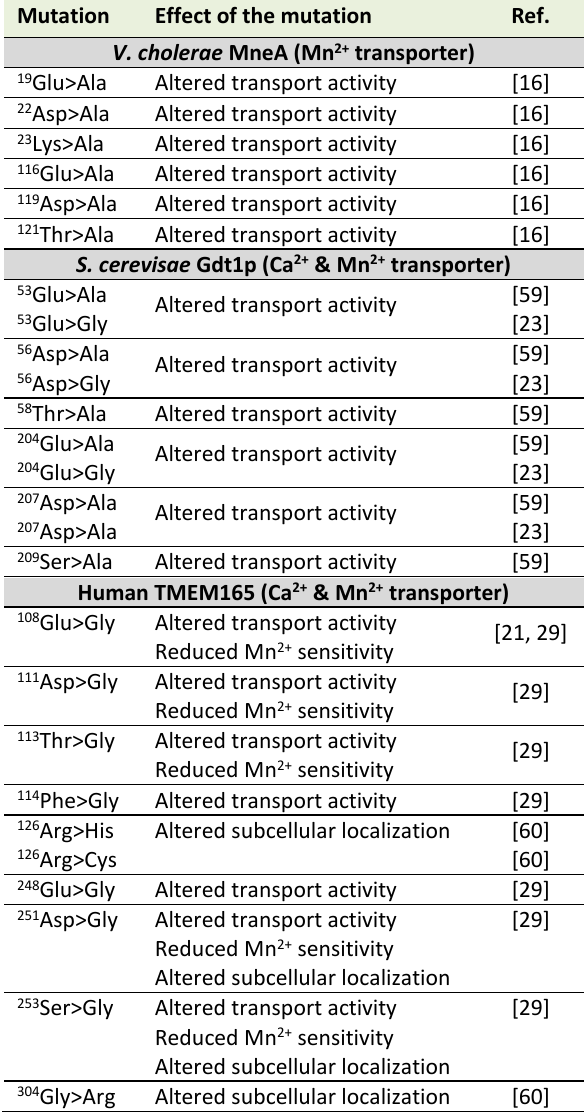
TABLE 1. Summary of the mutations within the UPF0016 mem- bers MneA ( V. cholerae ), Gdt1p ( S. cerevisiae ), and TMEM165 (human) that have an effect on their transport function, stabil- ity, or subcellular